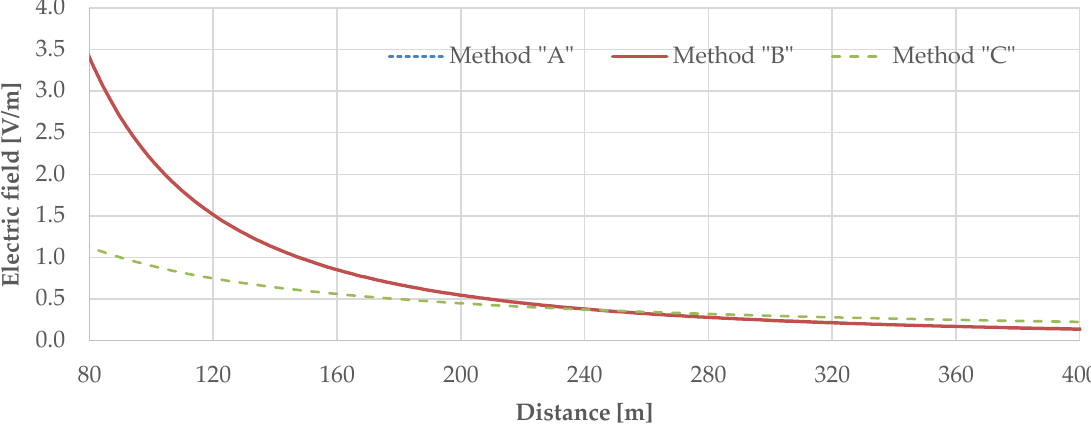
Figure 17. Electric field strength diagram, with respect to distance in the near outer area of the breakwater (80 m < r < 400 m), with three methods, “A”, “B” and “C”, for the case of Stachtoroi ( θ w = 0.2718 ◦ , θ = 210 ◦ , r 1 = 1.0 m, r 2 = 17.0 m, r 3 = 10.0 m, r ∞ = 150 km, ρ s = 1,000 Ω · m, ρ d = 100 Ω · m). Therefore, method “C” of the linear current source is recommended within the breakwater area, inside the breakwater, and on the outer area, for up to the distance r C → A , beyond which method “A” (or “B”, since in that region they are identical) of the point current source, gives smaller values of electric field strength, as the wedge of seawater of angle θ w better approximates the seawater mass than does the limited horizontal water layer, defined by the method “C” (of the linear current source) at long distances. The smooth transition between the two methods takes place at a distance where the respective electric field strengths of methods “A” and “C” (for the external area of the breakwater) are equal. Therefore, by equalizing Equations (7) or (23) and (44), the distance r C → A results as equal